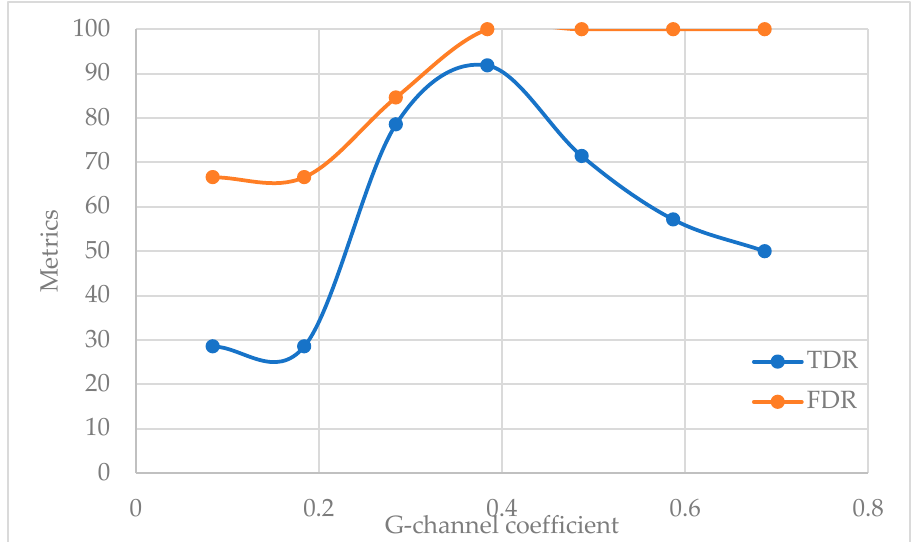
Figure 5. G channel coefficient and detection accuracy graph.